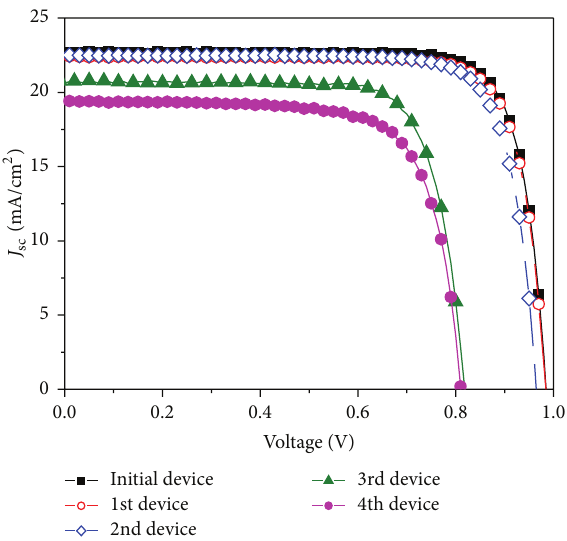
Figure 3: Photovoltaic performance comparison of single-junction solar cells grown on the new and recycled GaAs